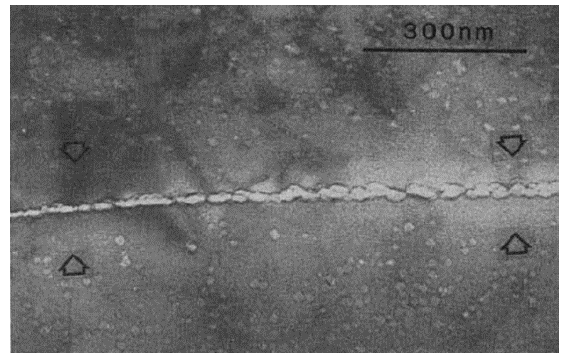
Figure 7. Large He bubbles along GB in He irradiated austenitic steel. As indicated by arrows, BDZs with width of tens of nanometers distribute symmetrically on both sides of GB. Reprinted with permission from [74]; Copyright 1983 Informa UK Limited.